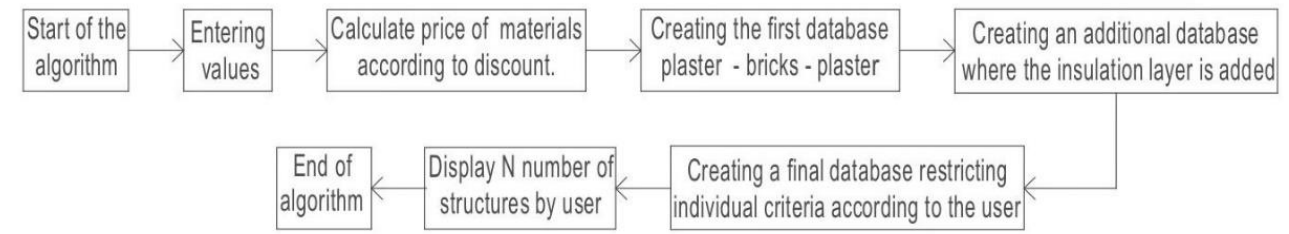
8 of 19 Table 1. Categories for external structures according to standard ČSN 73 0540-2. ČSN 73 0540-2 (W/(m 2 ·K)) U rec,20 Required